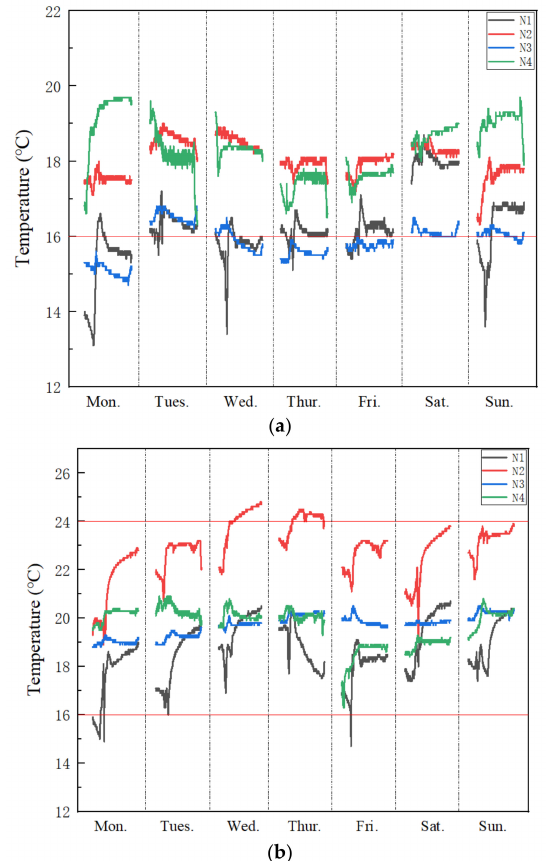
Figure 4. Temperature measurement results. ( a ) Before heating, ( b ) After